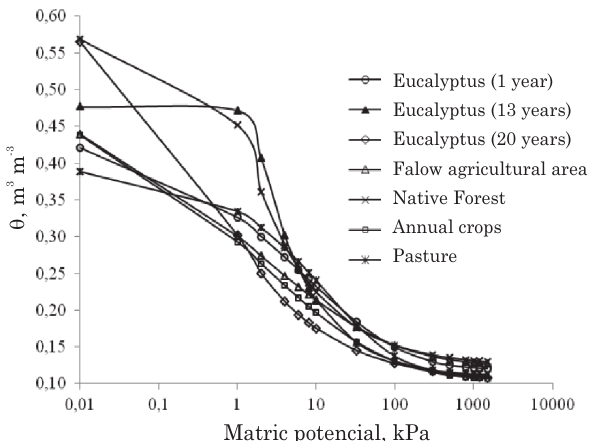
Figure 1. Soil water retention curves, adjusted by the van Genuchten model, in the 0-0.1 m layer as a function of soil use.